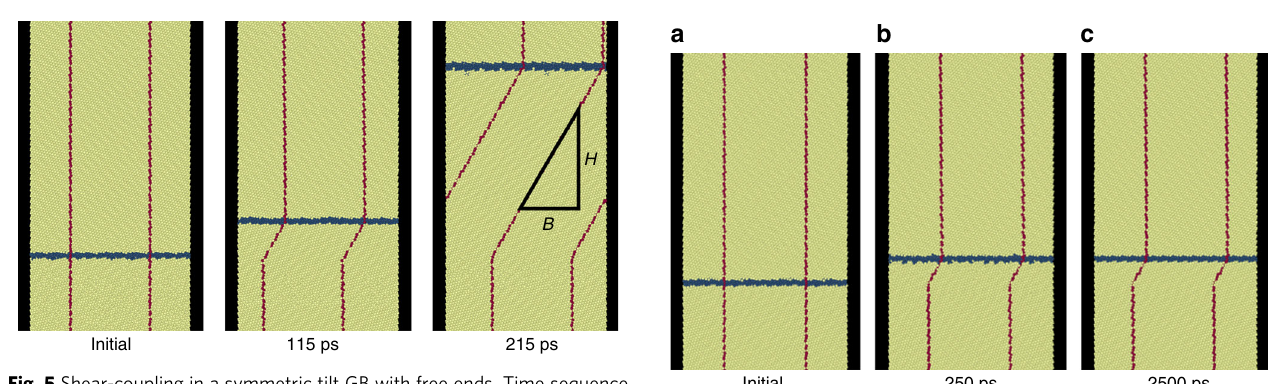
Fig. 5 Shear-coupling in a symmetric tilt GB with free ends. Time sequence depicting shear-coupling in a Σ 39[111] θ = 32.2° symmetric-tilt GB for a difference in energy density between the two crystals 54 Ψ = 8.0 meV Å − 3 at 300 K with free top and bottom surfaces. The blue horizontal and red vertical lines are the GB position and fi ducial mark (red atoms), respectively. As the GB migrates, the upper grain shifts right. Two periods of the simulation cell are shown in the horizontal direction and the free top and bottom surfaces are outside the sections of the simulation cell shown grain shear-couple, what disconnection reactions are possible at